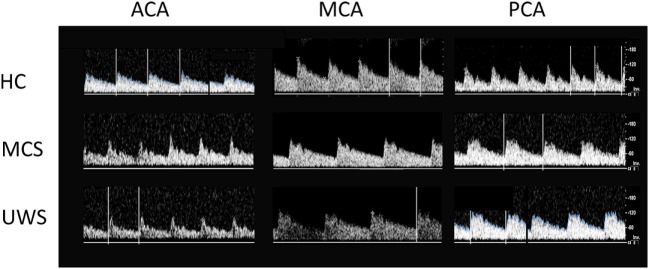
Shows the transcranial Doppler waveforms (on the right) from left middle (MCA), anterior (ACA), and posterior (PCA) cerebral arteries at rest in a representative subject for each group (HC, MCS, and UWS). Flow velocity (in centimeter per second, right vertical bar) are provided.